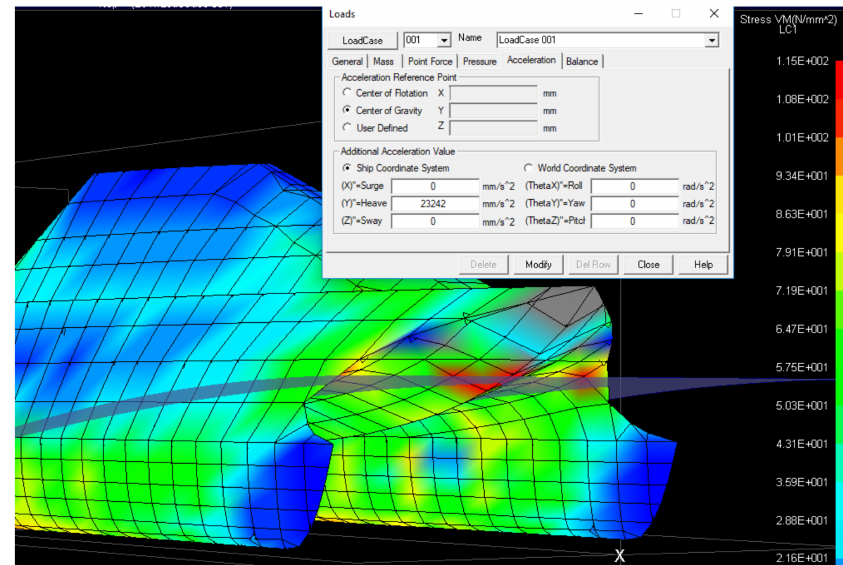
Figure 11. Additional acceleration applied due to the related sea